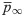
Variation of the long-term fraction p¯∞ of cooperators with average degree k and cost-to-benefit ratio ρ, in the sculling game on model networks.(a)-(c) random regular networks; (d)-(f) exponential networks; and (g)-(i) scale-free networks. (a)(d)(g) p¯∞ versus k and ρ. The dashed lines show the graph of the relation 1ρ-1=k-1. (b)(e)(h) p¯∞ versus k when ρ = 1.1. The dashed lines show the critical degree kc=1ρ-1+1. (d)(f)(i) p¯∞ versus ρ when k = 4. The dashed lines show the value of the critical cost-to-benefit ratio ρc=1k-1+1.